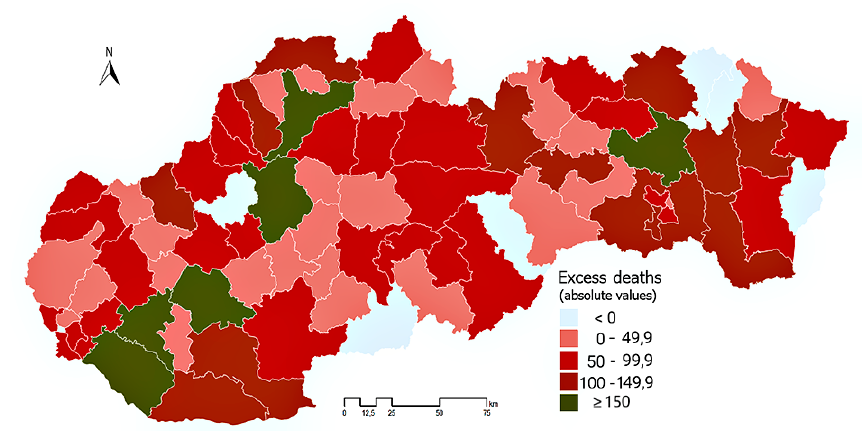
Figure 13. Excessive mortality in Slovakia during the Covid-19 pandemic (“raw” number of deaths) Source: The Human Mortality Database (2021), Our World in Data (2021)